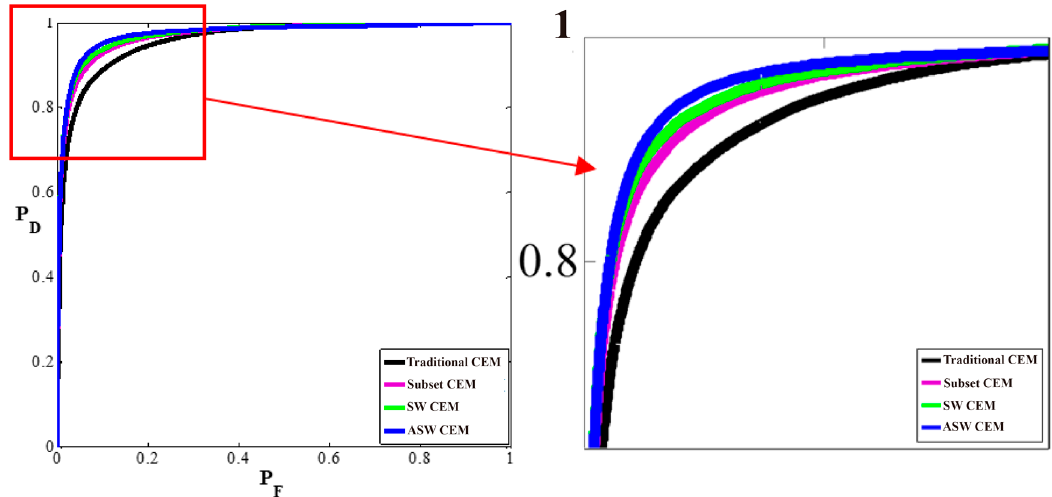
Figure 18. ROC curves of local and global CEMs on Region 1.